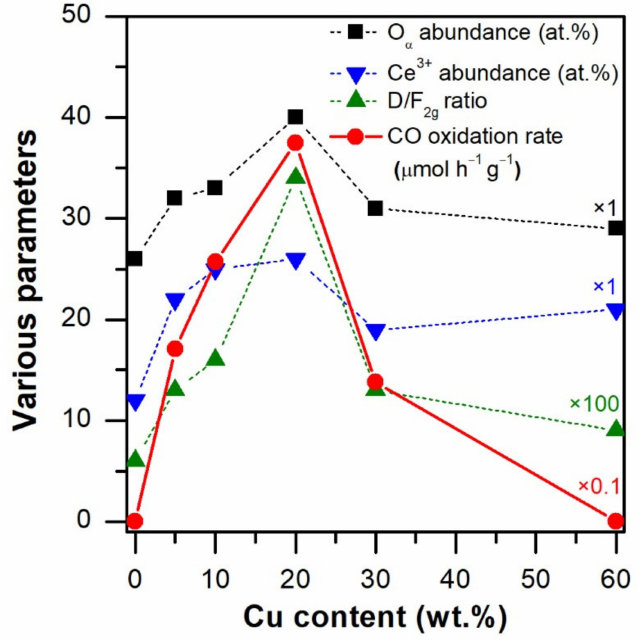
Figure 8. Trends of various parameters of the different CuCeO x catalysts reported as a function of the Cu wt.% content.